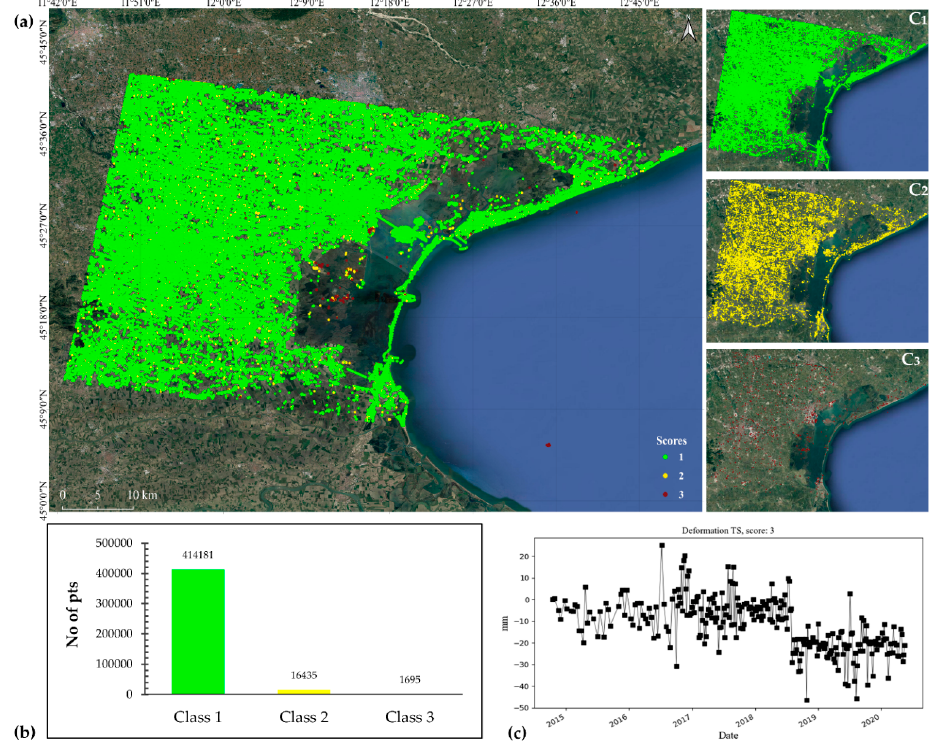
Figure 5. Map of point scores of Venice, Italy − (a) with PSs classified in C 1 (green color), C 2 (yellow color) and C 3 (maroon color), (b) Bar graph of the number of PSs per each class and (c) an example of a phase TS with unwrapping error taken from C 3 .